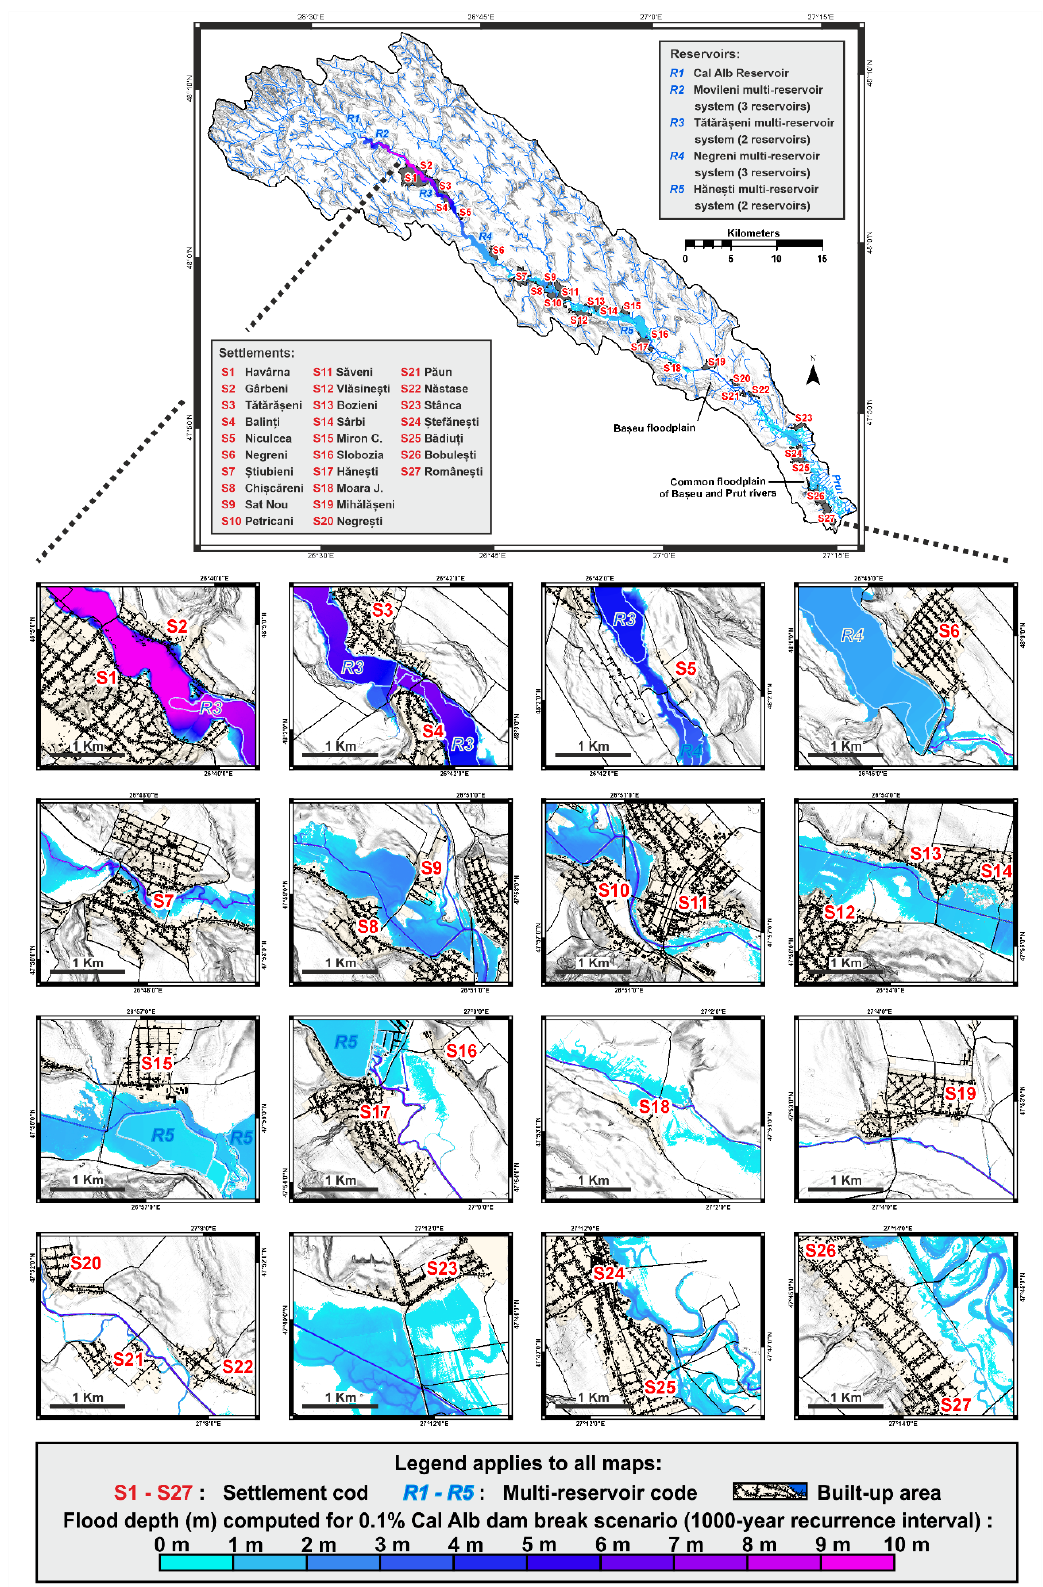
Figure 5. Flood depth (m) within built-up area of 27 settlements located downstream of the Cal Alb reservoir computed for the worst dam break scenarios with 0.1% (1000-year) recurrence intervals.